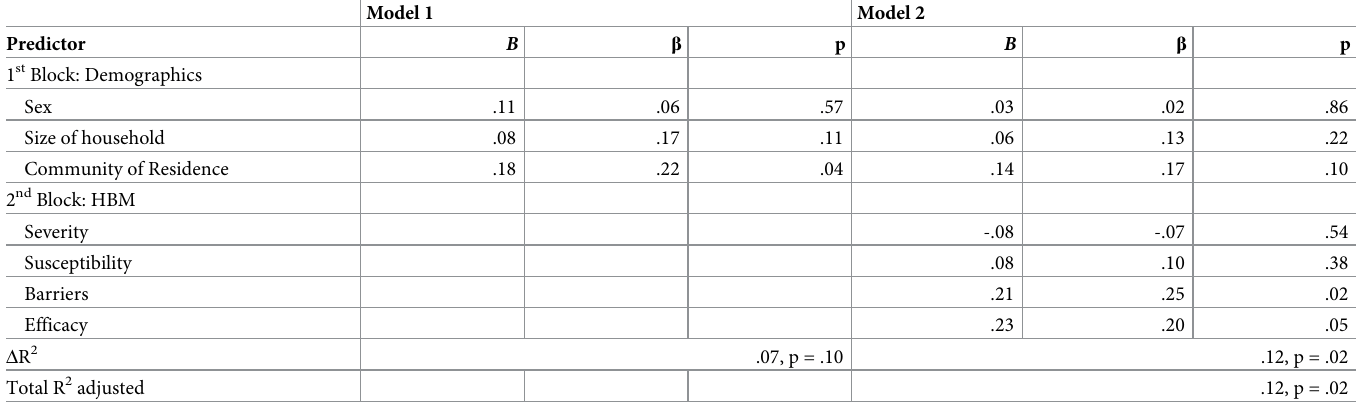
Table 3. Regression results using intention to keep home free of triatomines as the